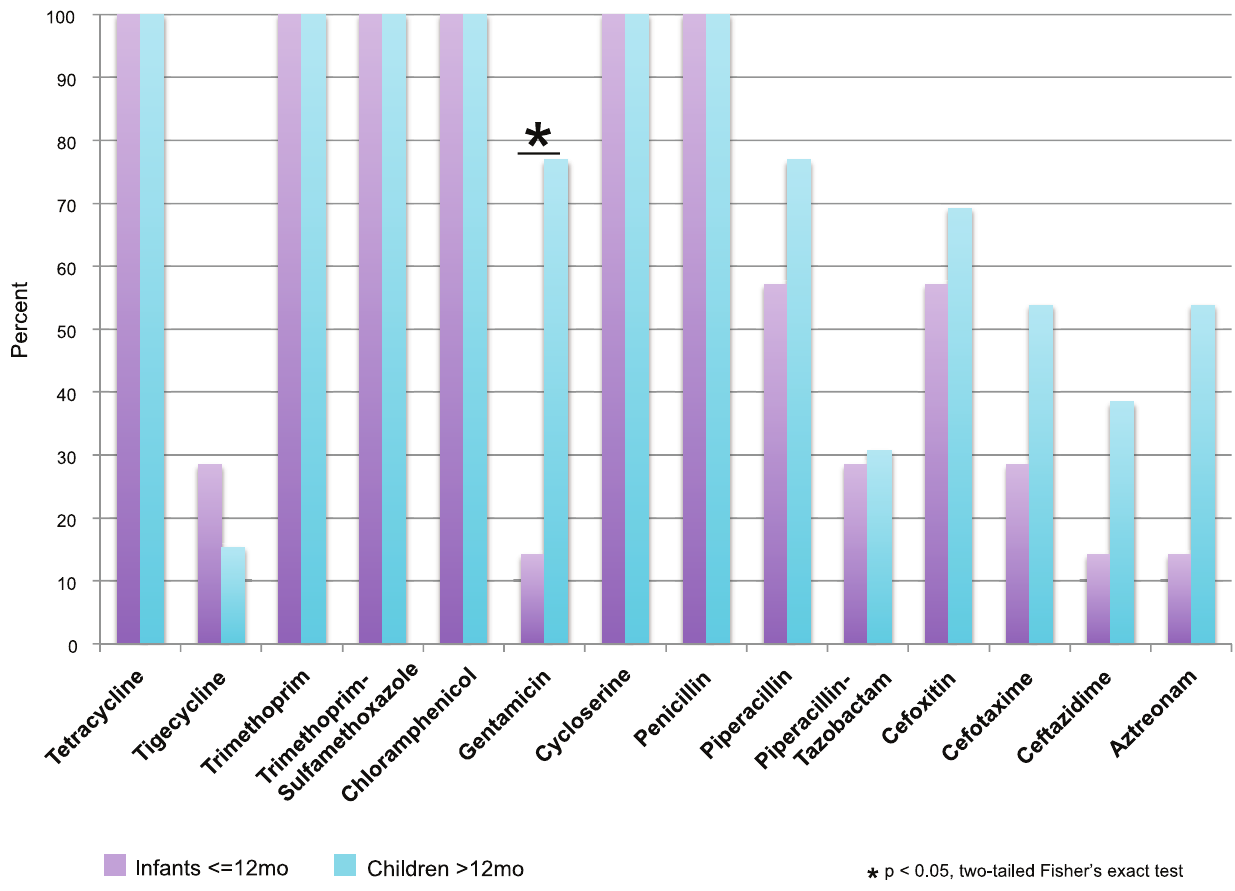
Figure 1. Antibiotic selections for which resistance was observed. The percent of libraries from infants (N=8) and children and adolescents (N=12) generating colonies resistant to 14 antibiotics is plotted. Two libraries that were , 0.1 GB in size were excluded, as they did not have enough genetic diversity to accurately represent the resistance in their source metagenome. Not shown are four antibiotics for which no resistance was found: ciprofloxacin, meropenem, colistin, and cefepime.